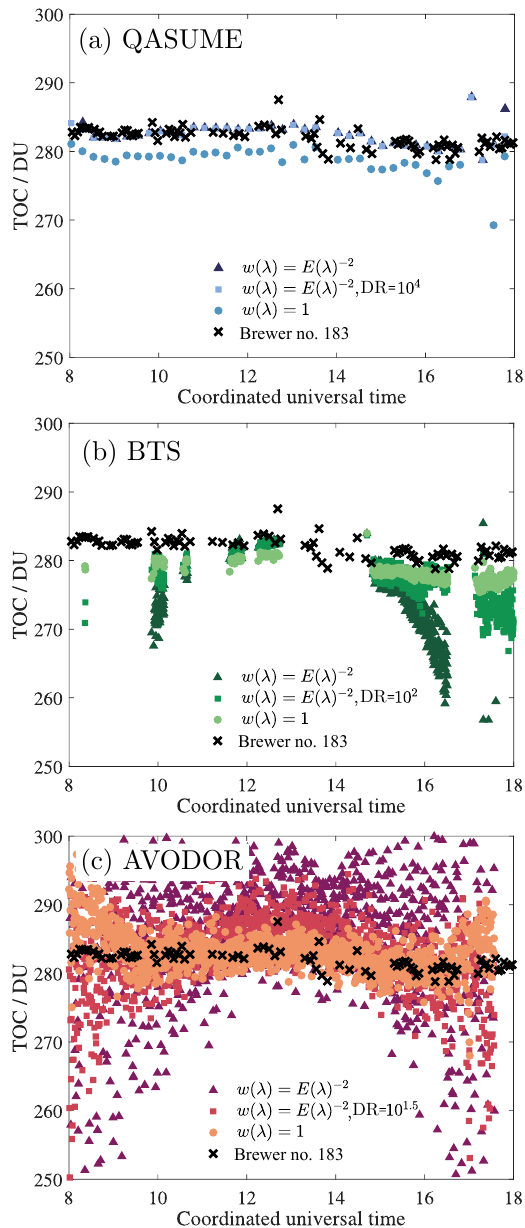
Figure A1. TOC values during the day estimated using different weightings in the least squares minimization for QASUME (a) , BTS (b) and AVODOR (c) . TOC values for Brewer #183 are plot- ted as black crosses for comparison. The colour codes and the asso- ciated figure legends denote the weighting and the dynamic range (DR)